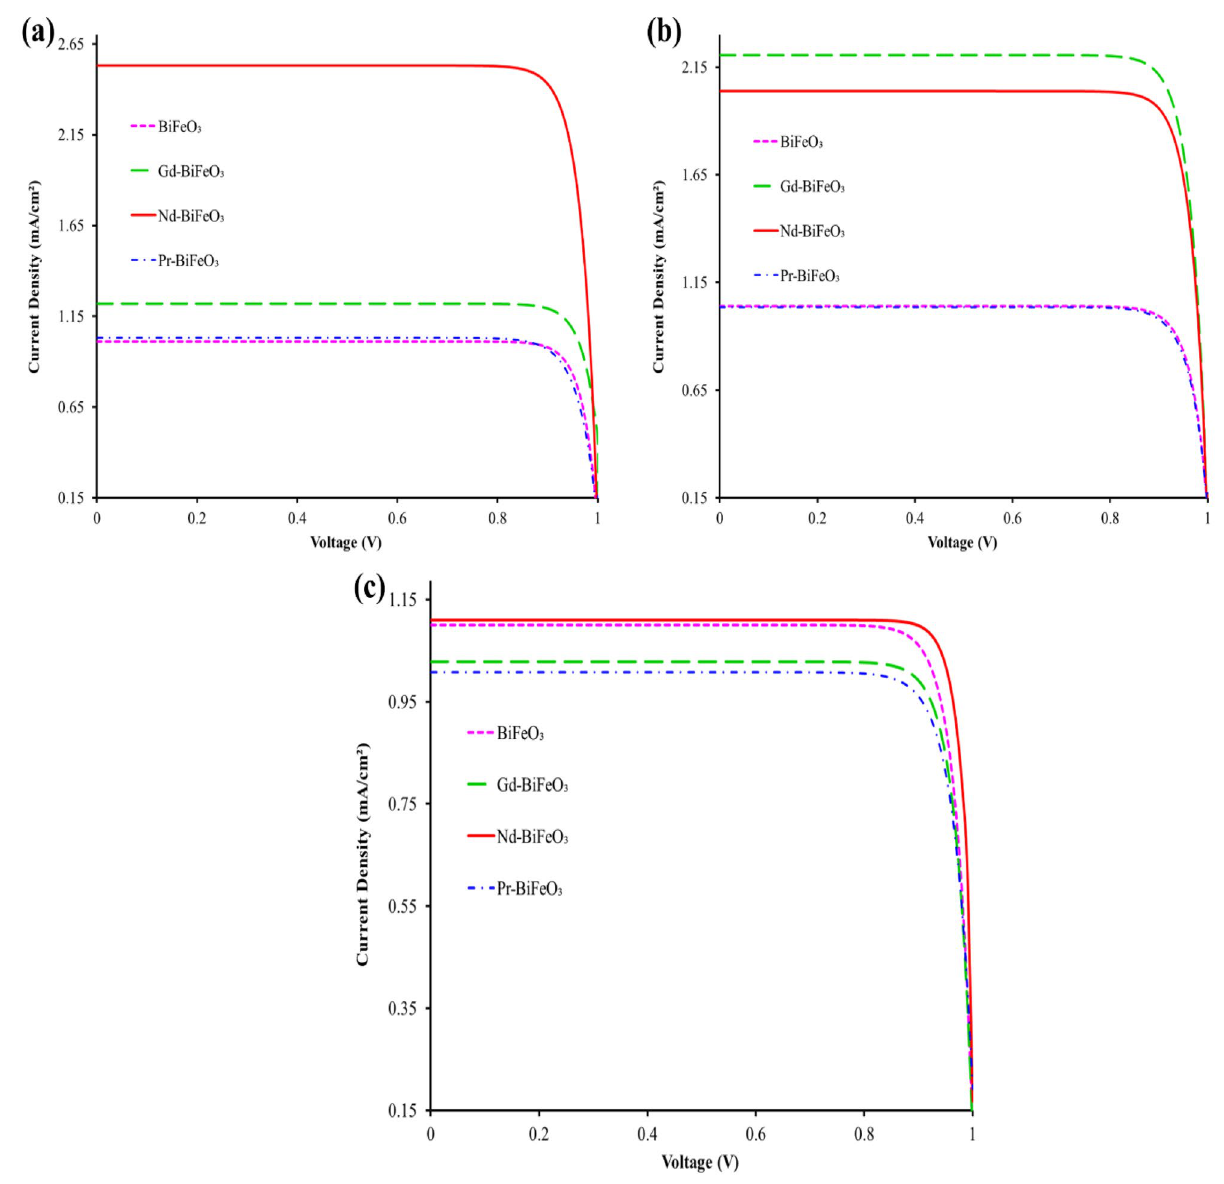
Figure 10. I–V curves of DSSC based on photoanodes by using: ( a ) Mint ( Mentha ), ( b ) Kiwi ( Actinidia deliciosa ), and ( c ) Malachite green dye solution.